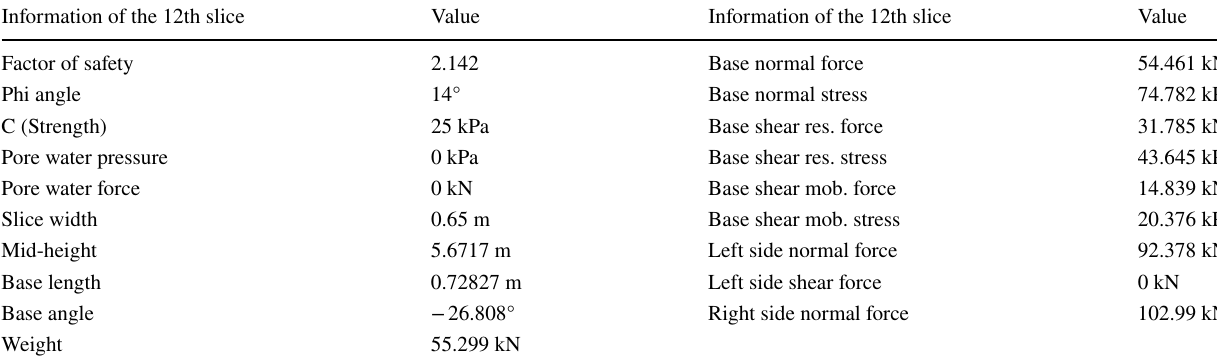
Information of the 12th